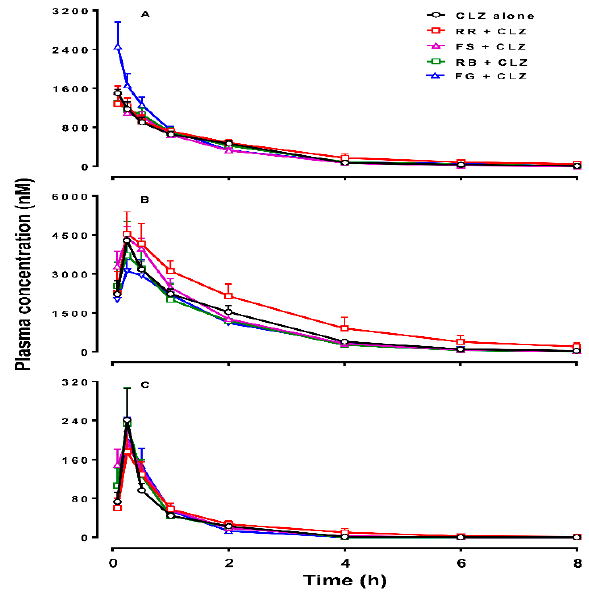
Figure 2. Plasma concentrations of clozapine (CLZ, A ), norclozapine (norCLZ, B ), and clozapine N -oxide (CLZ N -oxide, C ) over time in rats treated with an intraperitoneal injection of 10 mg/kg of CLZ for 11 days alone ( n = 5), or pretreated orally with Radix Rehmanniae (RR; n = 6), Fructus Schisandrae (FS; n = 4), Radix Bupleuri (RB; n = 4), and Fructus Gardeniae (FG; n = 4), respectively, every day. The data are presented as mean ± SEM.